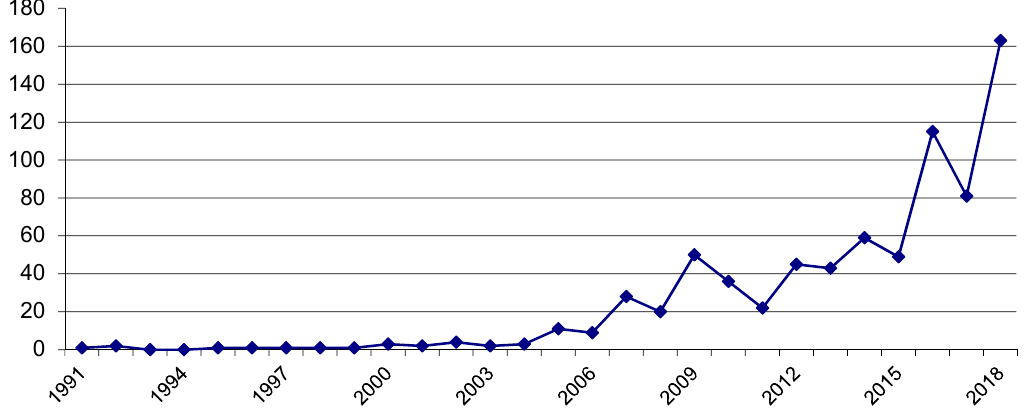
Figure 3. Publishing trends (number of papers) in the area of “coopetition” (using Scopus Database). The initial data analysis shows the most contributing authors in this field (please see Table 2). Table 2. The top 10 contributing authors in the area of coopetition (Scopus Database), full counting. Author/Affiliation